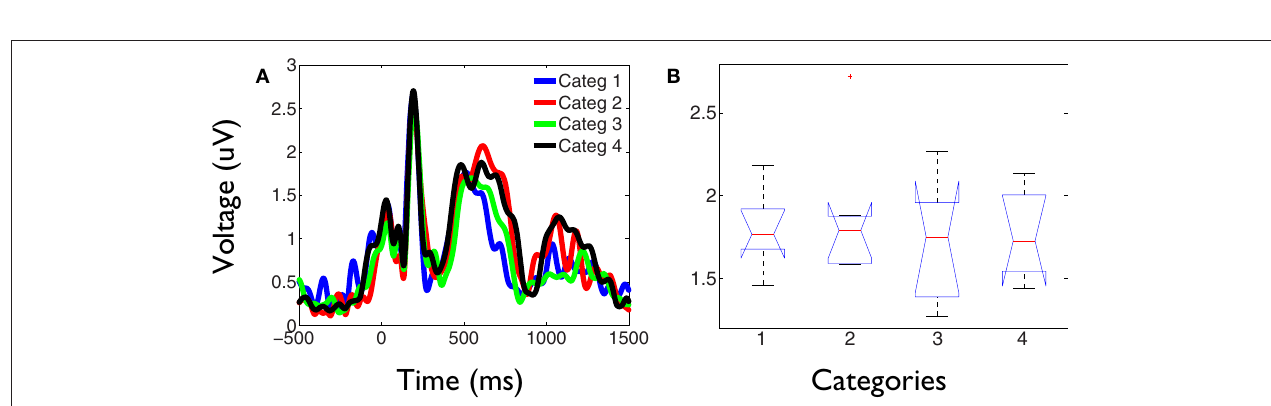
FIGURE 6 | Stronger phase synchronization for the kept in mind category is not associated to an increase of the time-locked global field power. (A) GFP obtained for each category during the task. The signals represent the average across all subjects. Despite the intrusive alpha activity, it can be observed that category 2 is not associated to a greater evoked activity at any latency during the task.